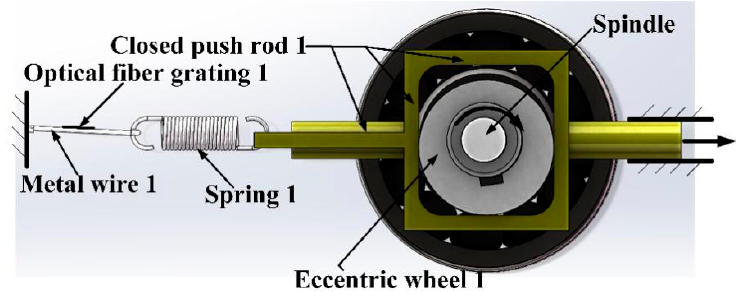
Figure 3. The displacement measurement of the push cam mechanism.